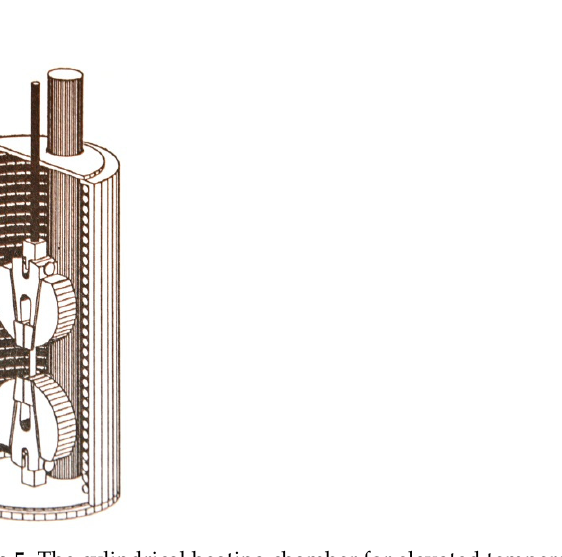
Figure 5. The cylindrical heating chamber for elevated temperature testing.